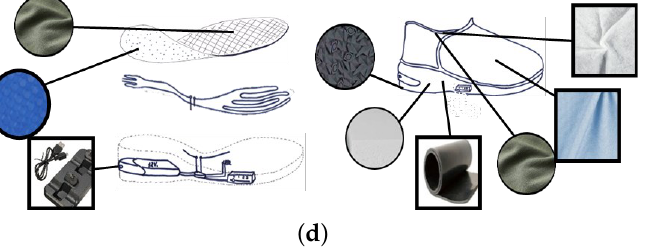
Figure 2. Graphical representation of concepts: ( a ) Tough Slipper ; ( b ) Teddy Slipper ; ( c ) Ecofriendly Slipper ; ( d ) Techno Slipper .